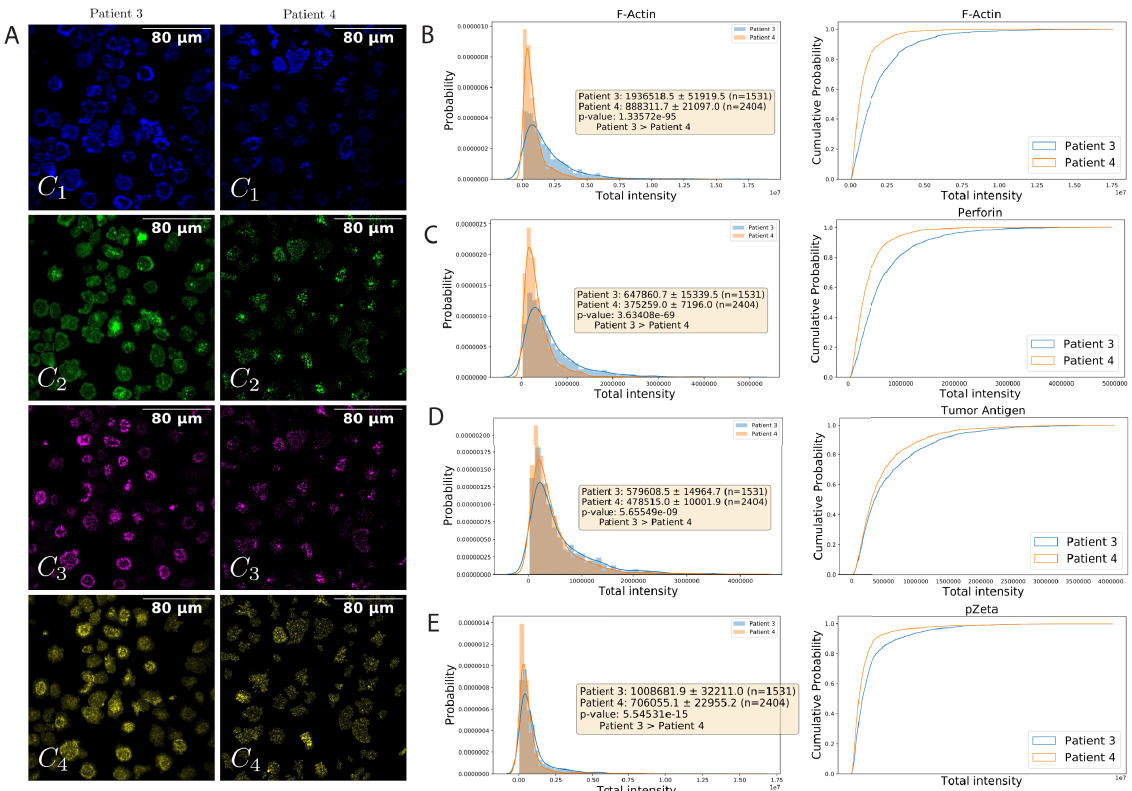
Fig 6. The total intensity in 4 channels. F-actin at row 1 (channel 1), perforin at row 2 (channel 2), tumor antigen at row 3 (channel 3), pZeta at row 4 (channel 4). (A) Shows one sample for each patient. The left side is for patient #3 and the right side for patient #4. In these images, the regions that do not belong to any predicted masks from ANNs are removed. Auto-contrast makes cells visible to human eyes (they do not affect real analysis). The (B), (C), (D), and (E) show the total intensity distribution and cumulative probability of two patients using fully trained networks across all channels for all counted cells from the evaluation phase. The figures also show the mean, variance, and the number of cells detected for each channel separately.